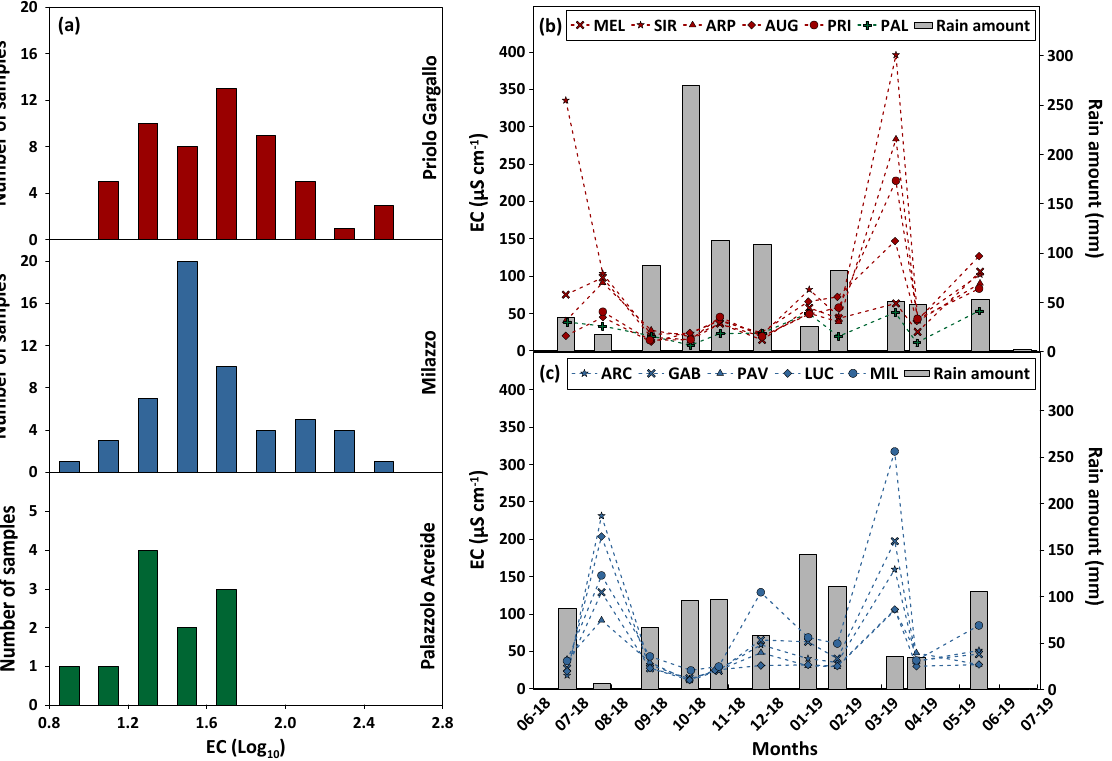
Figure 7. ( a ) The EC distribution (Log 10 ) of rainwater samples that were collected from June 2018 to June 2019 at Priolo Gargallo, Milazzo, and Palazzolo Acreide study areas, respectively. On the right side, seasonal variability of the EC values and average rain amount at Priolo Gargallo ( b ) and Milazzo ( c ) study areas.